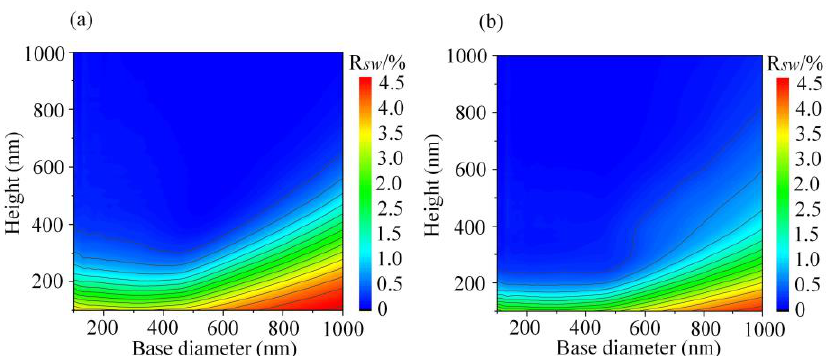
Figure 2. Contour plots of solar-weighted reflectance of ( a ) NOA63 CSMS/PET and ( b ) NOA63 PSMS/PET.